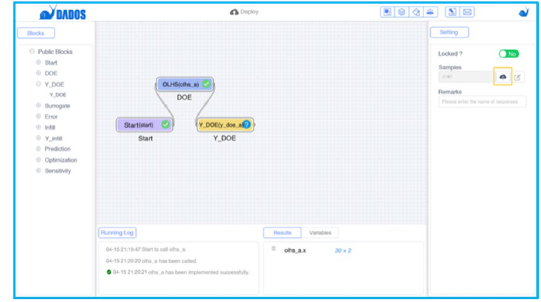
Figure 14 Configuration of the Y_DOE block for the numerical example